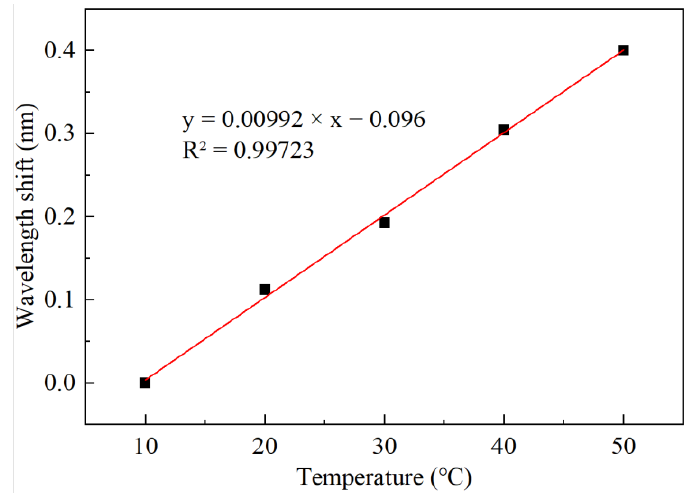
Figure 10. Variation in the FBG sensor’s wavelength with temperature.